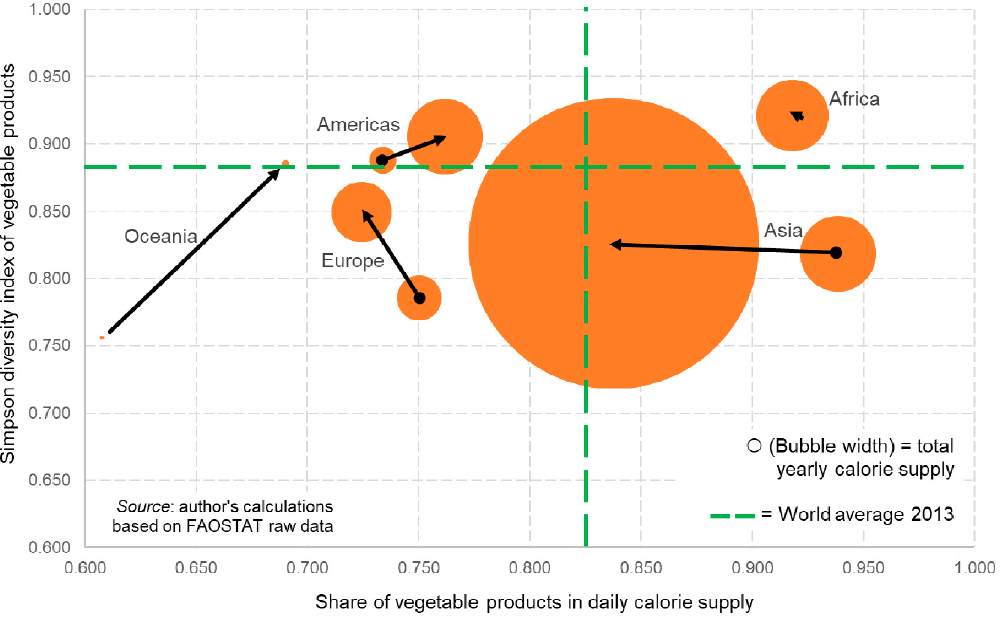
Figure 1. World diet situation, by macro-region, 1961 and 2013.